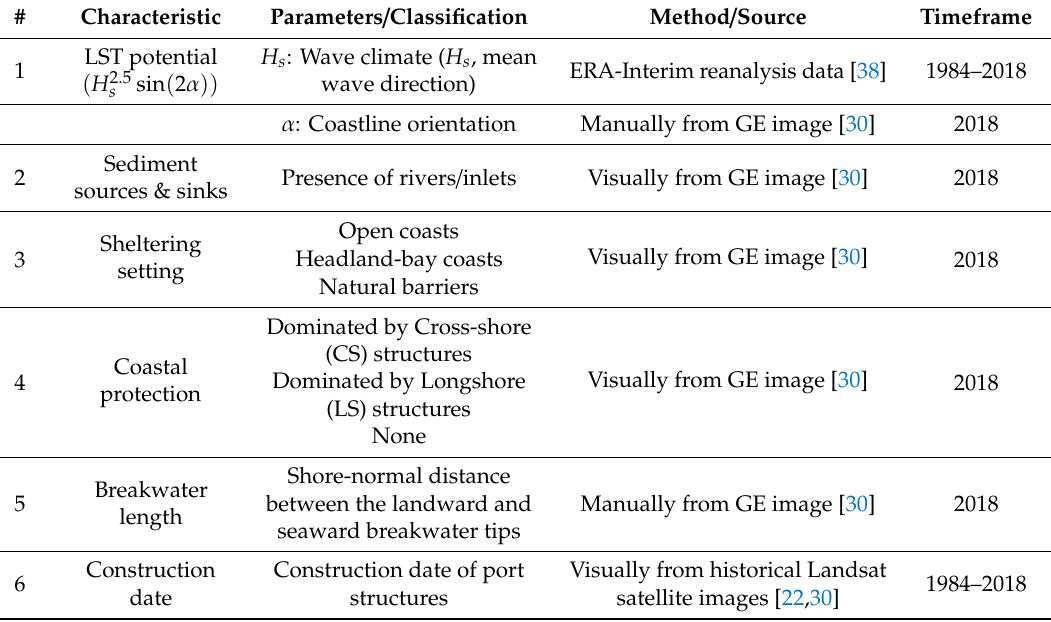
Table 1. Overview of the characteristics obtained for the African seaports in the Pan-African Seaports Database as well as the methods and time frames used in the analysis of these